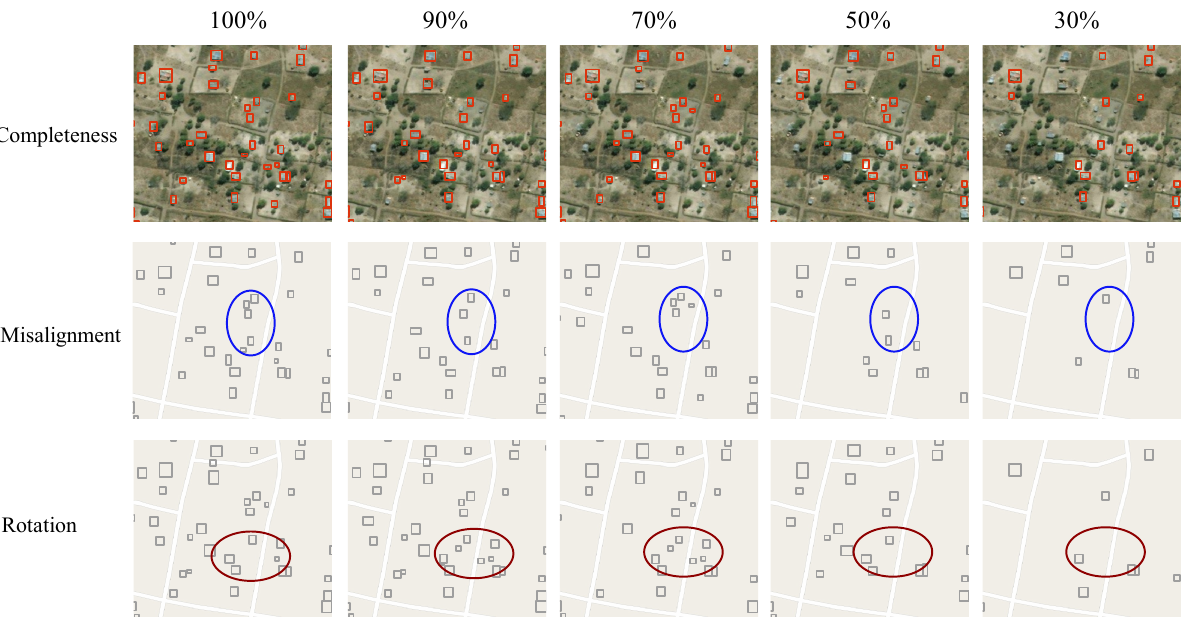
Figure 6. Prediction maps of OSM missing building in the test area w.r.t different simulated error sources in training data. Basemaps contrast to Bing aerial